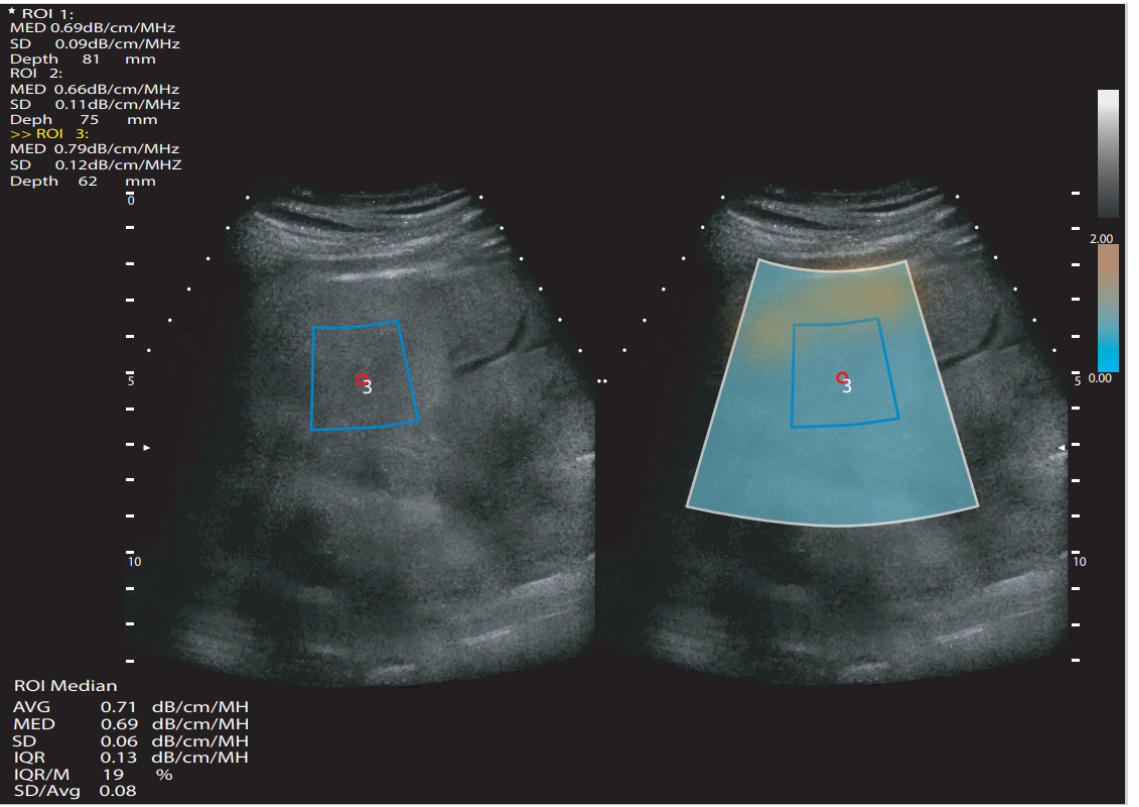
Figure 2. Simplified attenuation ultrasound measurement scheme. White quadrangle—area of measurement; blue quadrangle—region of interest; ROI—region of interest; SD—standard deviation. dB/cm/MHz—decibels per centimeter per megahertz; MED or M—median value; IQR—interquartile range; AVG or Avg—average value; mm—millimeters.